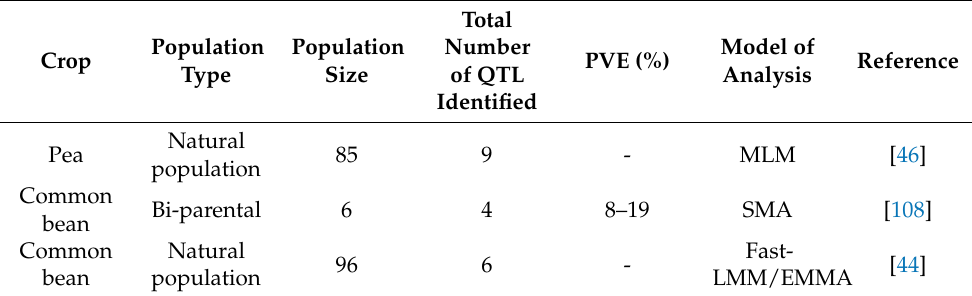
Table 4. QTL identified for folate content in